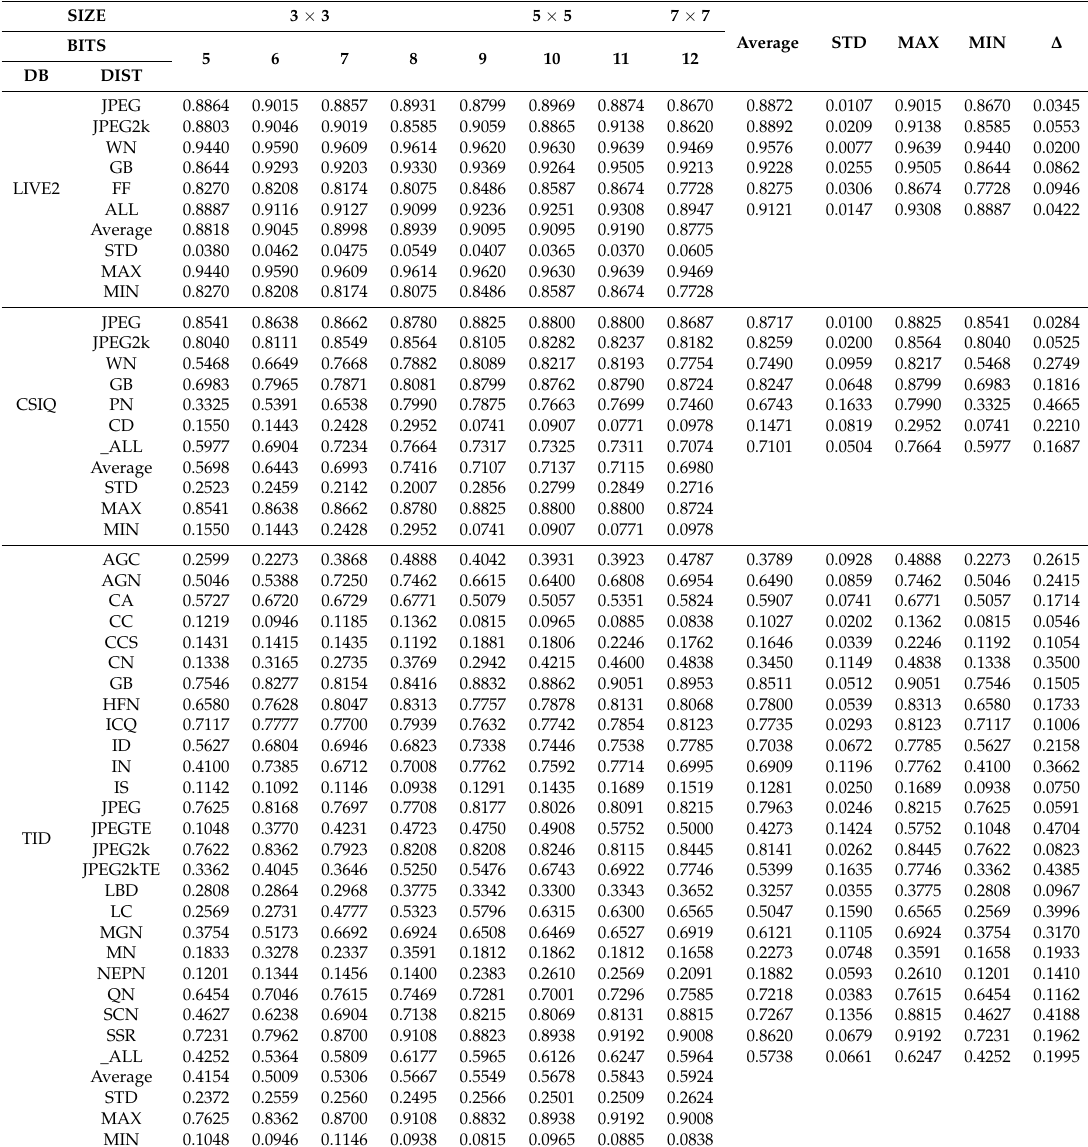
Table 3. Average SROCC of 1000 runs of simulations on tested databases using BSIF